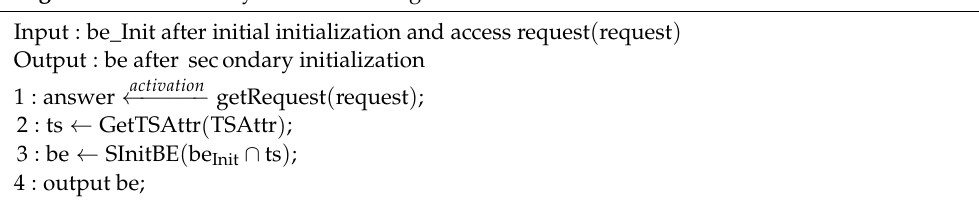
Algorithm 2: Secondary initialization